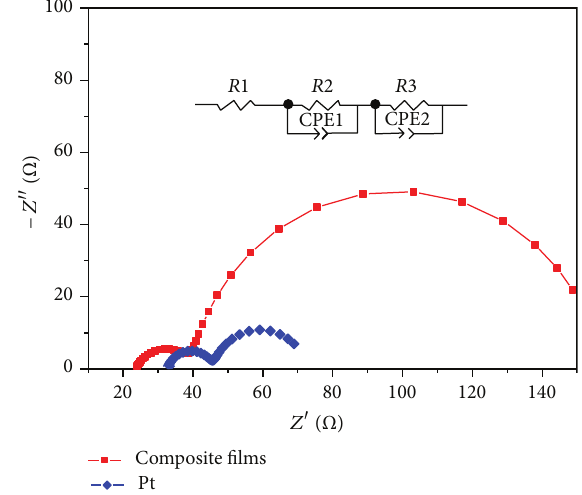
Figure 7: EIS spectra of the DSSCs with the composite films counter electrode and Pt electrode. The cells were measured with the frequency range of 100mHz to 100